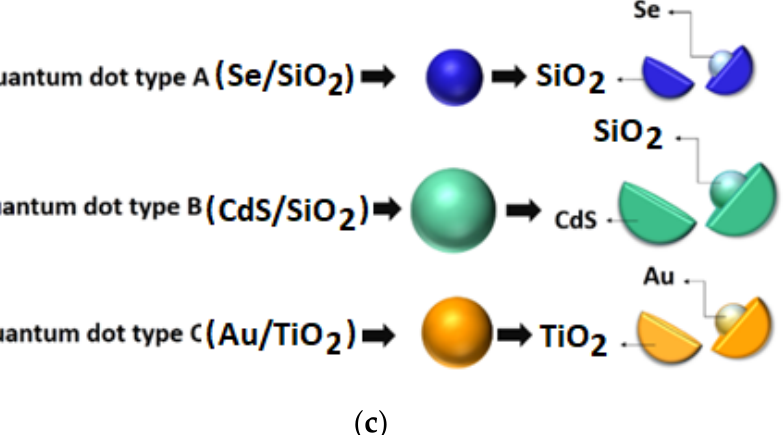
Figure 1. The proposed schematic of the considered optical antenna. ( a ) Dimensions of the considered antenna. ( b ) Configuration of components in the antenna (host matrix, doped quantum dots, attached photodetector, incident light, and guided light). ( c ) Types of the core–shell quantum dots which are doped inside the antenna’s structure.